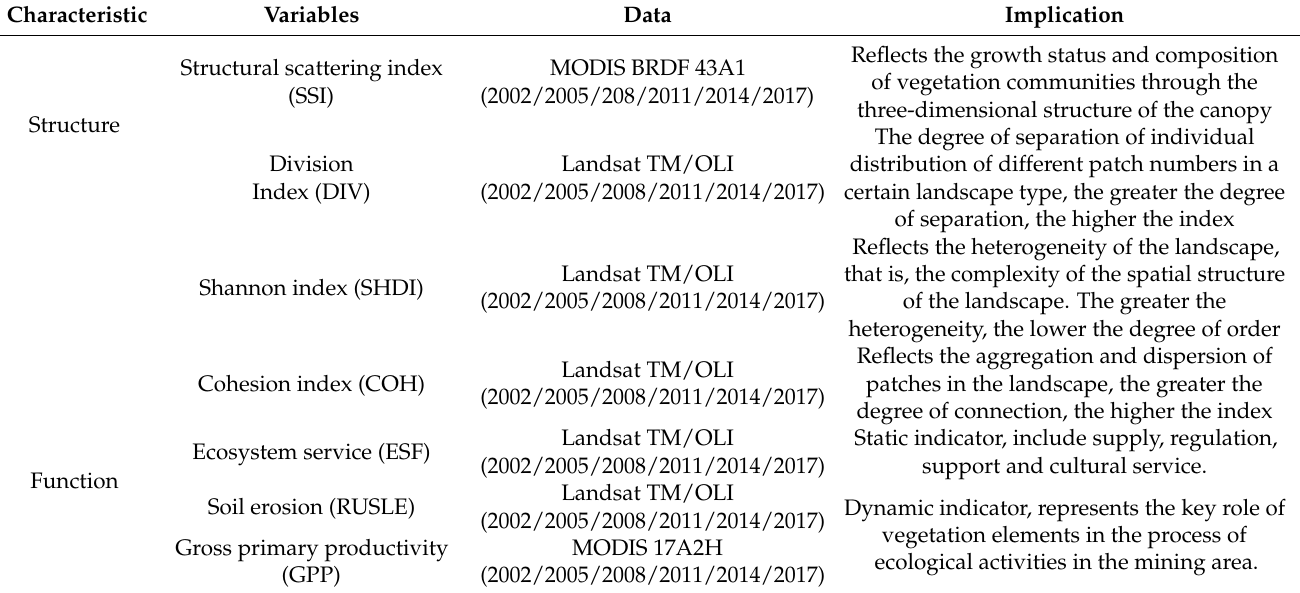
Table 1. Structural and functional variables used for ecological stability in the coal mining area.